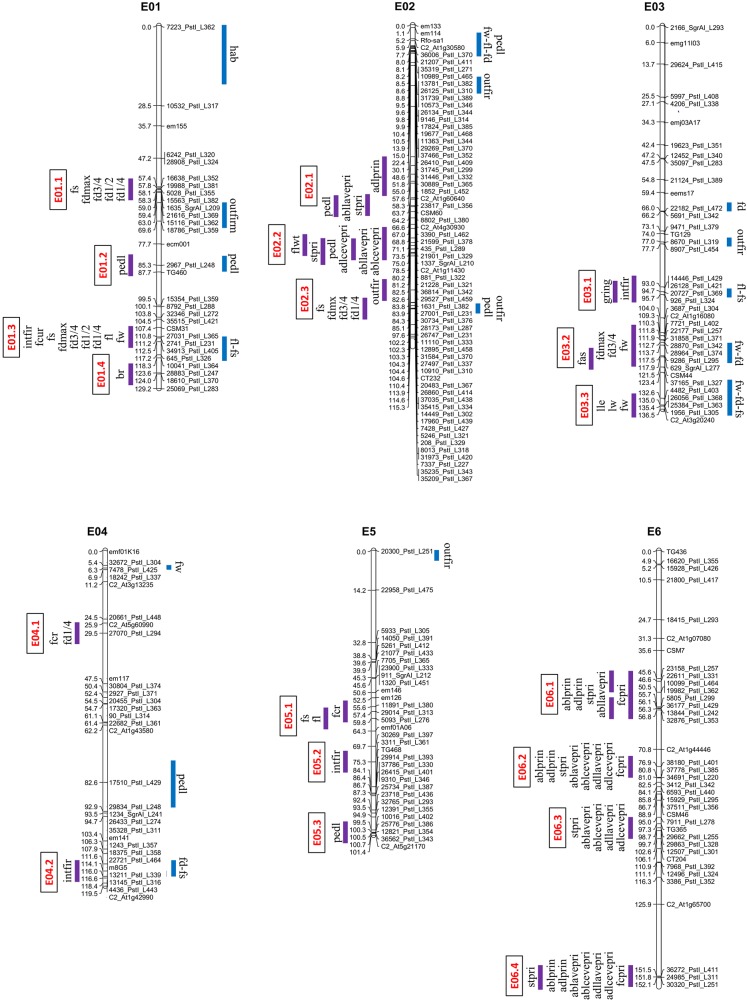
Regions identified by GWA in eggplant LG E01-E06 in comparison to QTL locations described by Portis et al. [2].The GWA outcome is given to the left of each chromosome (the vertical bars represent a ±3.4 cM interval around the position of the associated SNP loci) and the various regions are marked in red. The QTL locations are shown to the right of each chromosome.